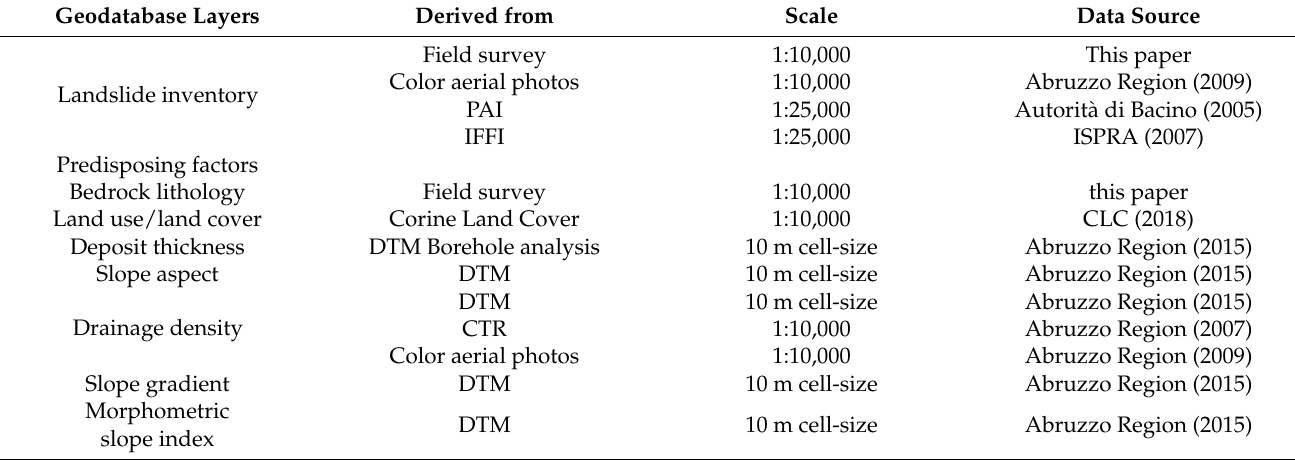
Table 1. Sources of input